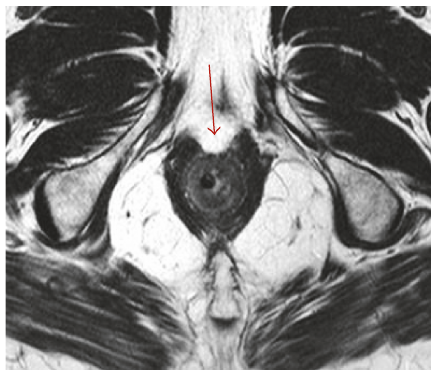
Figure 7: MR T2-weighted axial image of the anal sphincter complex taken perpendicular to the intra-anal marker: a focal defect (arrow) is visible from 11 to 1 (anal clock) after STARR procedure, responsible of episodes of fecal